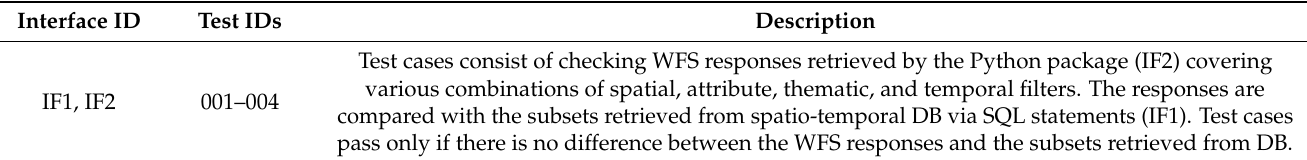
Table 3. Overview of integration tests. Interface IDs reflect the system architecture as presented in Figure